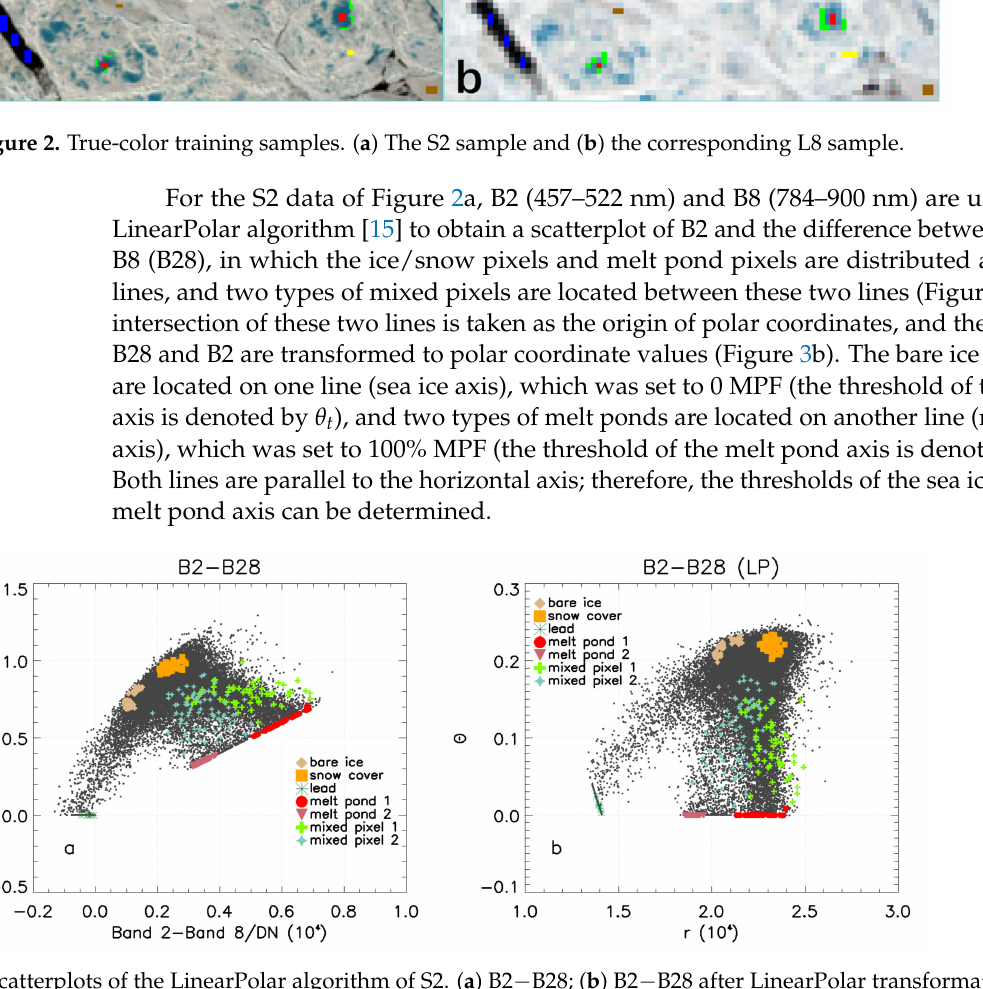
Figure 3. The scatterplots of the LinearPolar algorithm of S2. ( a ) B2 − B28; ( b ) B2 − B28 after LinearPolar transformation. In Figure 3, we use the DN values to obtain the scatterplots. The conversion